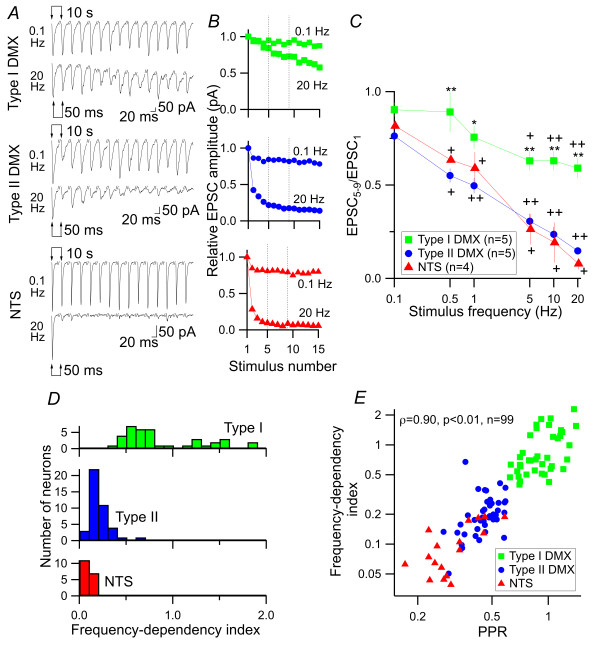
Frequency dependence of EPSC following repetitive stimulation of the DVC neurons. A, EPSC traces in response to repetitive stimulation at 0.1 Hz (top of each panel) and 20 Hz (bottom). Top to bottom: representative responses of type I and type II DMX neurons and a dm-cNTS (NTS) neuron. Traces in-between the responses were removed so that the changes in the EPSCs at different frequencies could be directly compared on the same time-scale. B, normalized EPSC amplitude at each stimulation (stimulus number 1-15) at 0.1 Hz and 20 Hz. Each marker and vertical bar represent the mean and SE of the values in 39 (type I DMX), 42 (type II DMX) and 18 (dm-cNTS) neurons. The length of the vertical SE bars was often smaller than the marker size, which made them masked behind the markers; this suggests fairly similar trajectories among neurons. Note the marked frequency-dependent depression at 20 Hz, especially in type II DMX and dm-cNTS neurons. Two vertical broken lines indicate the range of the 5th to 9th responses, in which typical depression patterns of the EPSC amplitude at 20-Hz stimulation were observed and used for evaluating the fdi. C, the depression of EPSC amplitude during the course of stimulation depended on the stimulation frequency. Abscissa, stimulus frequency; ordinate, the degree of EPSC amplitude depression as evaluated by the mean amplitude of EPSC5 to EPSC9 (5 EPSC responses), which was normalized to that of EPSC1. **, p< 0.01; *, p < 0.05; Kruskal-Wallis test to compare type I, type II DMX and dm-cNTS neurons; +, p < 0.05; ++, p < 0.01; Mann-Whitney test to compare the (EPSC5-9)/EPSC1 values at different stimulation frequencies with that at 0.1-Hz stimulation in each neuron group. D, distribution of fdi values estimated from recordings in type I DMX, type II DMX and dm-cNTS neurons. E, relationship between the PPR (abscissa) and fdi. Summary of data obtained for all cell types. Note the strong positive correlation between fdi and PPR (Spearman's ρ = 0.90, p < 0.01, n = 99).